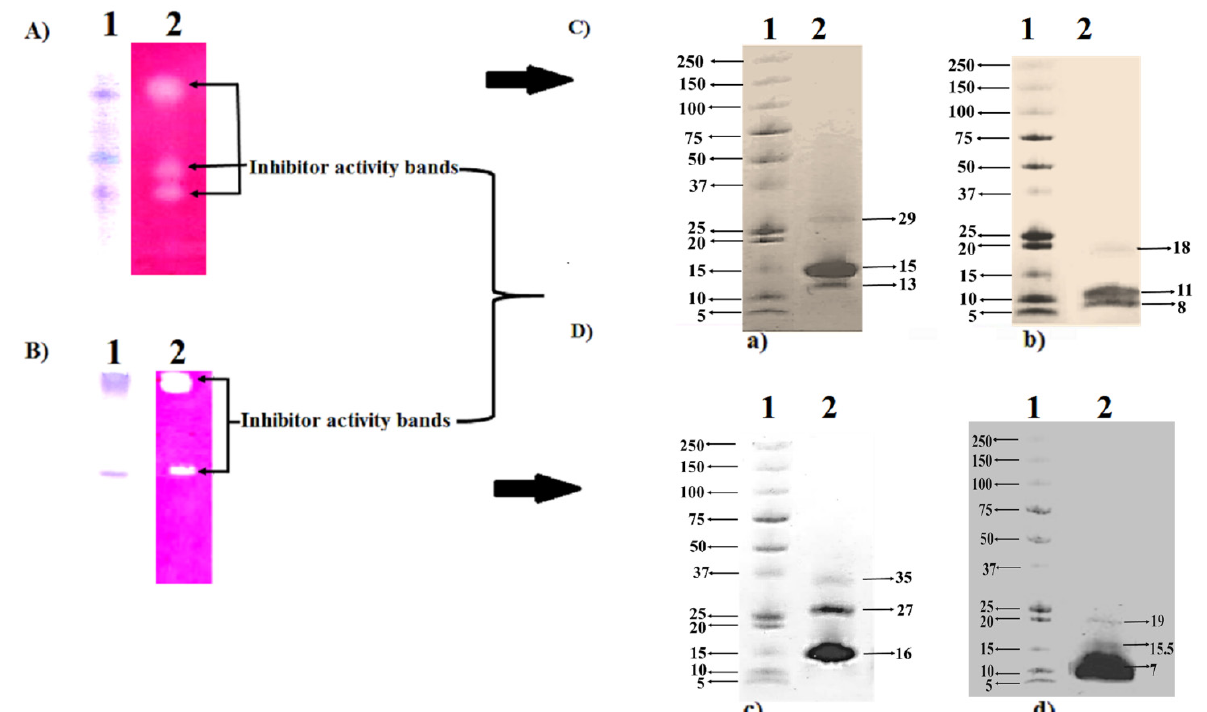
Figure 5. PAGE analysis of RP-HPLC fractions ( A ) (BLN-3347) and ( B ) (Rivette). ( A,B ) PI activity-stained native-PAGE gel